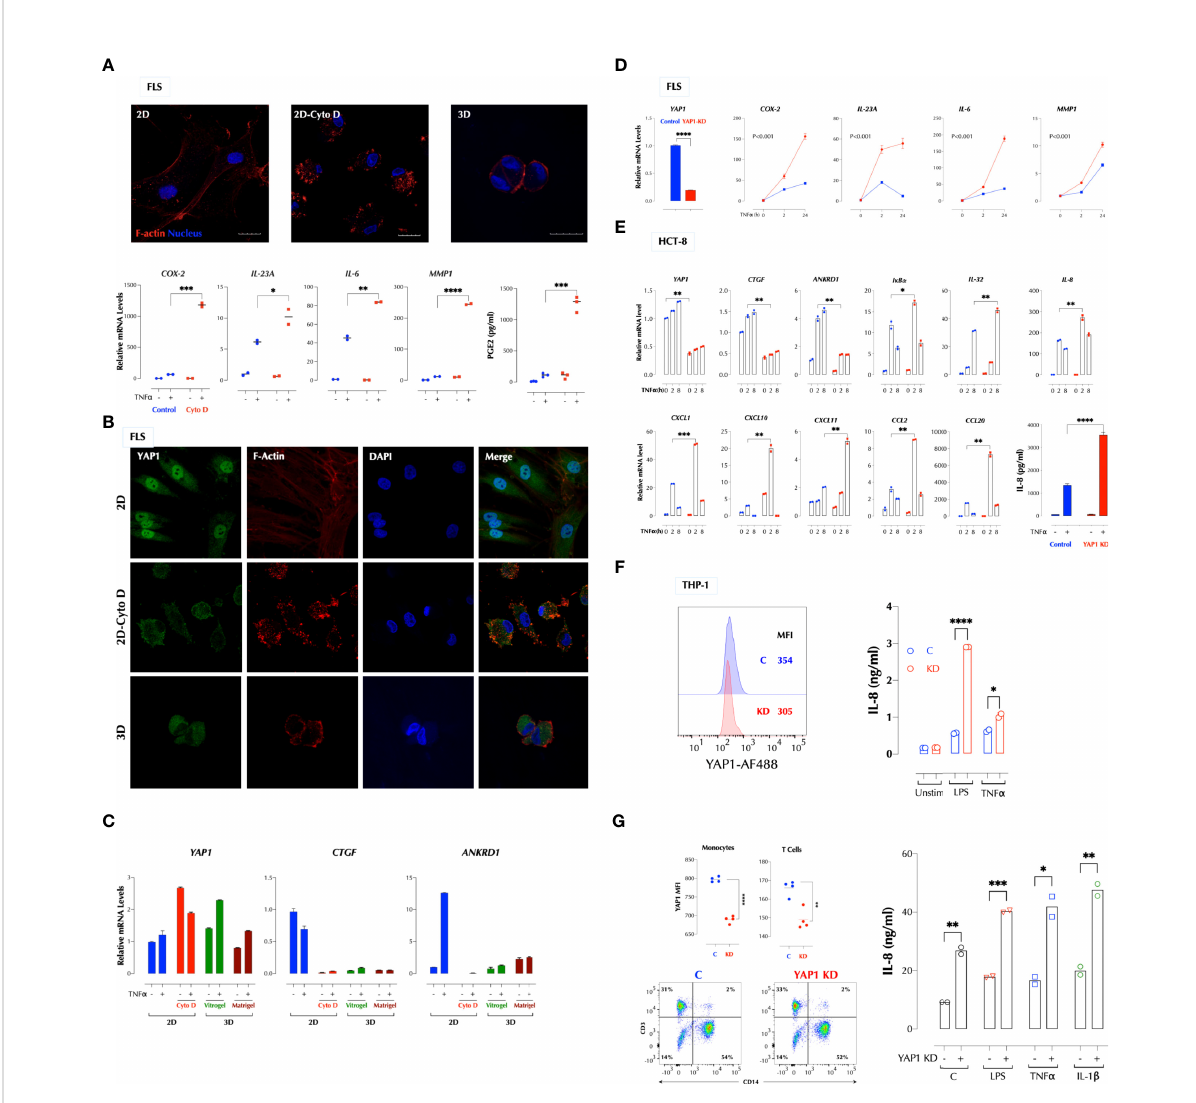
FIGURE 2 A high cytoskeletal tension suppresses the TNF response via YAP1. (A) Cytochalasin D (CytoD) disrupts actin polymerization and enhances the TNF response in FLS. FLS in 2D were treated with or without CytoD (1µg/ml) for 4h and stimulated with TNF a (1ng/ml) for 2h. PGE2 was measured by ELISA and the gene expression by qPCR. (B) Cytoskeletal tension regulates the YAP1 localization. FLS in 2D were treated with or without CytoD (1µg/ml) for 4h and FLS in 3D were cultured in Vitrogel for 7 days before staining YAP1 for confocal imaging. (C) A low cytoskeletal tension inhibits expression of YAP1 target genes in FLS. FLS in 2D were treated with or without CytoD (1µg/ml) for 4h and FLS in 3D were cultured in Vitrogel or Matrigel for 7 days before stimulation with TNF a (1ng/ml) for 2h for qPCR. PGE2 was measured after 24h stimulation by ELISA. (D-G). YAP1 knockdown in 2D enhances the TNF response in FLS (D) , HCT-8 (E) , THP-1 (F) , and human PBMCs (G) . YAP1 was silenced by siRNA and cells were stimulated with TNF a (1ng/ml) as indicated. The gene expression levels were measured by qPCR, IL-8 protein levels by ELISA, and YAP1 protein levels by fl ow cytometry. * P < 0.05, ** P < 0.01, *** P < 0.001, ****: